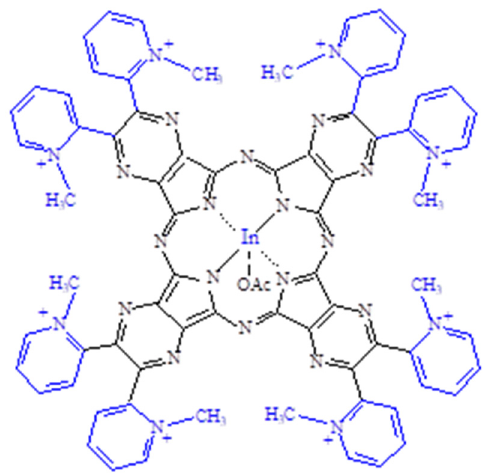
Figure 5. Schematic view of porphyrazine octacation [(2-Mepy) 8 TPyzPzIn(OAc)] 8+ (salted by I − anions; water neglected). anions; water